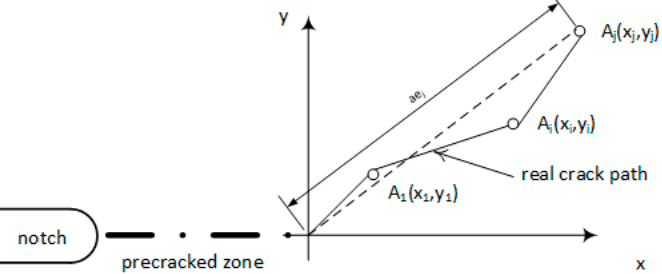
Figure 16. The coordinate system with the scheme of recording the X-Y crack tip location and crack length increment calculation; a ej —mixed mode fatigue crack growth length [18].